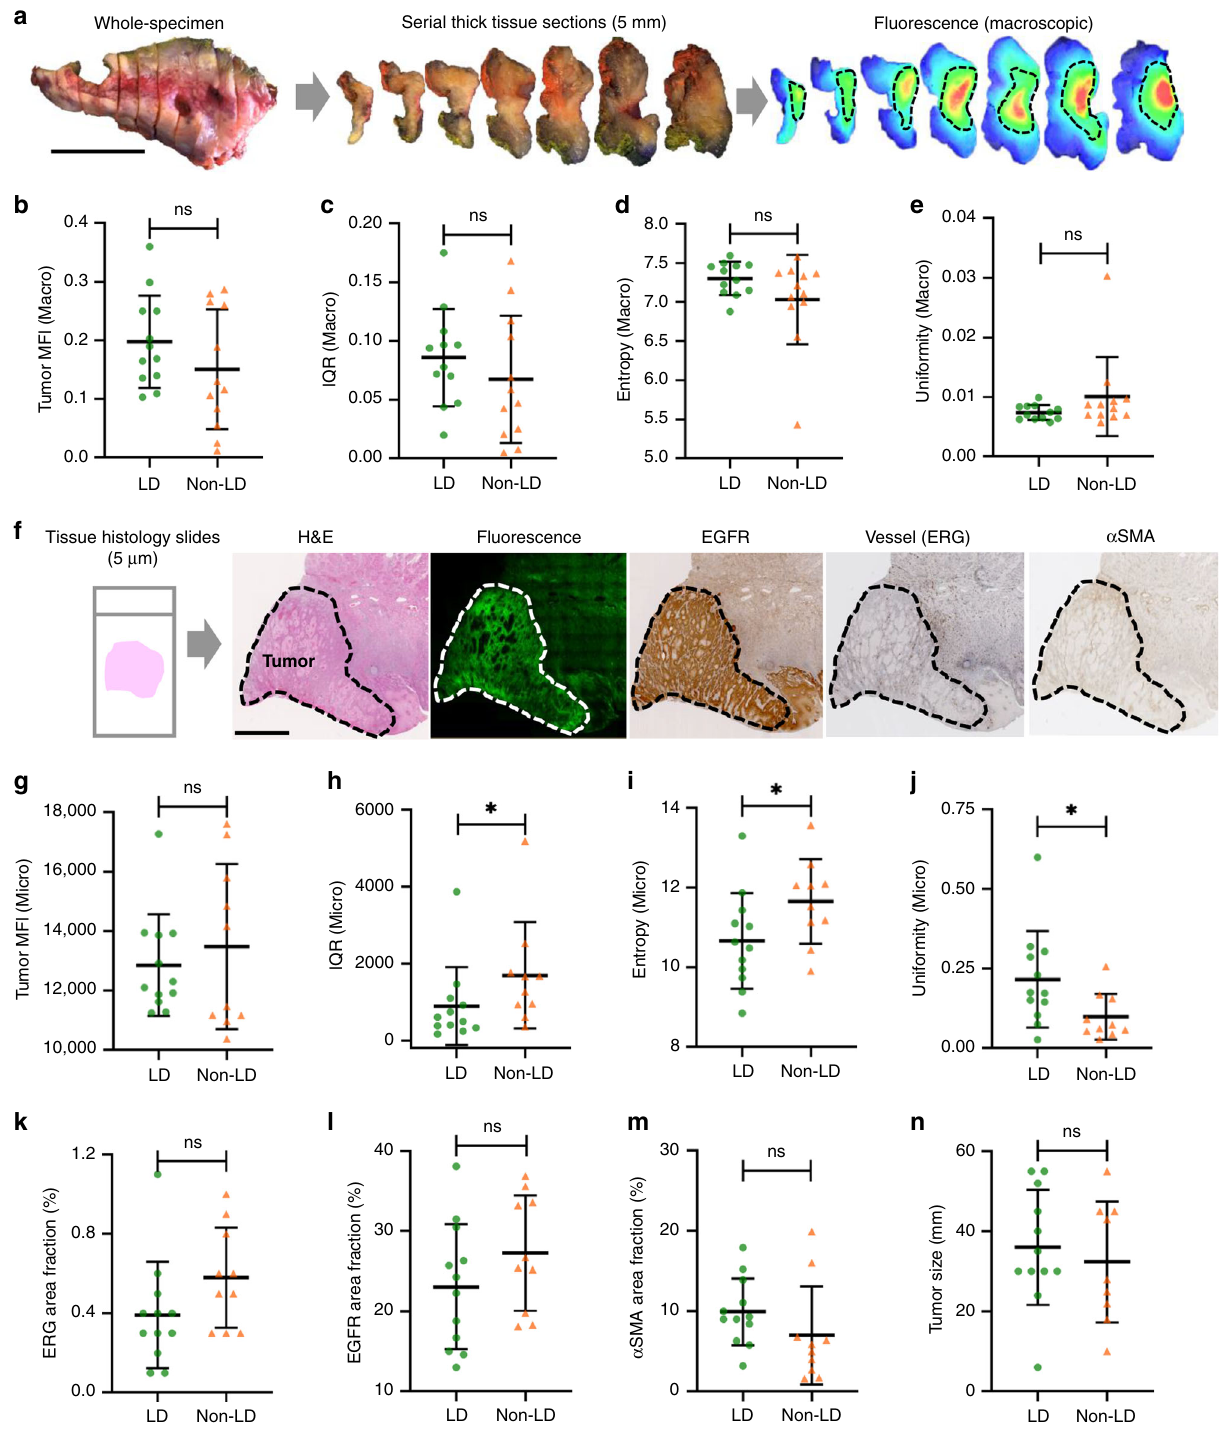
Fig. 4 A loading dose of unlabeled antibody signi fi cantly reduced heterogeneity of antibody distribution in tumors, which can be captured by microscopic imaging but not macroscopic imaging. a Schematic work fl ow of reconstructing the whole-tumor fl uorescence distribution and measuring antibody delivery by macroscopic imaging. b – e The tumor uptake as measured by the MFI, and the tumor antibody distribution quanti fi ed by IQR,entropy, and uniformity from macroscopic imaging showed no signi fi cant difference between the two dosing groups. b – e Tissue specimens were available in n = 12 patients in the LD group and n = 12 in the non-LD group. f Schematic work fl ow of measuring antibody delivery in tissue histological sections and tumor microenvironmental factors using microscopic imaging. g – j The tumor uptake measured by the MFI from microscopic imaging also showed no difference between the two groups, but the antibody distribution measured by IQR, entropy, and uniformity from microscopic imaging showed signi fi cantly higher heterogeneity in the non-LD group (* p < 0.05, ns: p > 0.05). p value = 0.030 h , 0.036 i , 0.025 j . k – n Vessel area fraction, EGFR area fraction, α SMA area fraction, and tumor size were not statistically different between the LD and the non-LD group. (Scale bar in a and f : 2 cm; graphs plotted mean with standard deviation). g – n Tissue specimens were available in n = 12 patients in LD group and n = 10 in the non-LD group. Mann – Whitney U test (two-tailed) was used in b – e , g – n